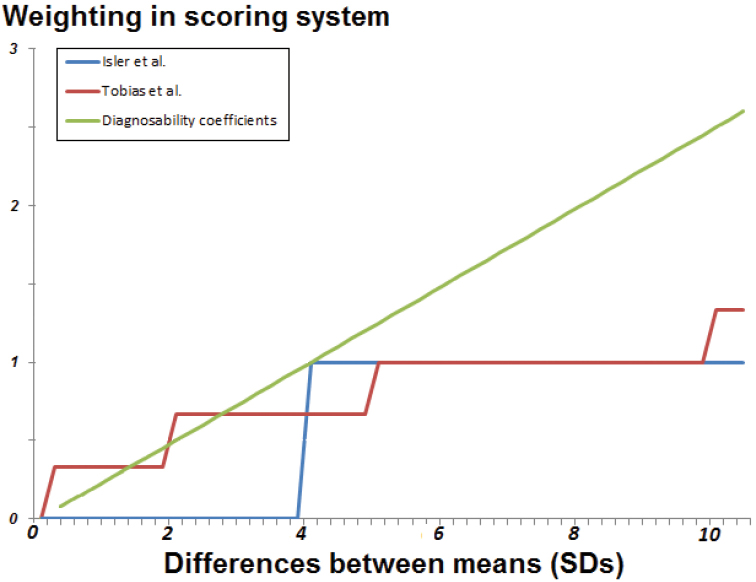
Graph illustrating the “hard cut-off” approaches of Isler et al. (1998) and Tobias et al. (2010). The y-axis shows the score attributed under the relevant system, weighted for 1 = diagnosability. The x-axis shows effect sizes. In addition to division by three, the Tobias et al. (2010) scores are treated more conservatively by assuming that bare pooled effect sizes are equivalent to controlled unpooled effect sizes. The scores for effect sizes at the lower end of the graph are somewhat artificial with a starting score of 0.34. This is based on the lowest recorded controlled unpooled effect size which passed a statistical significance test for biometrics (see Table 20). In reality, some lower differentiation with larger samples will be scored and some higher variation with lower samples will not be scored at all: see Tables 20–21.